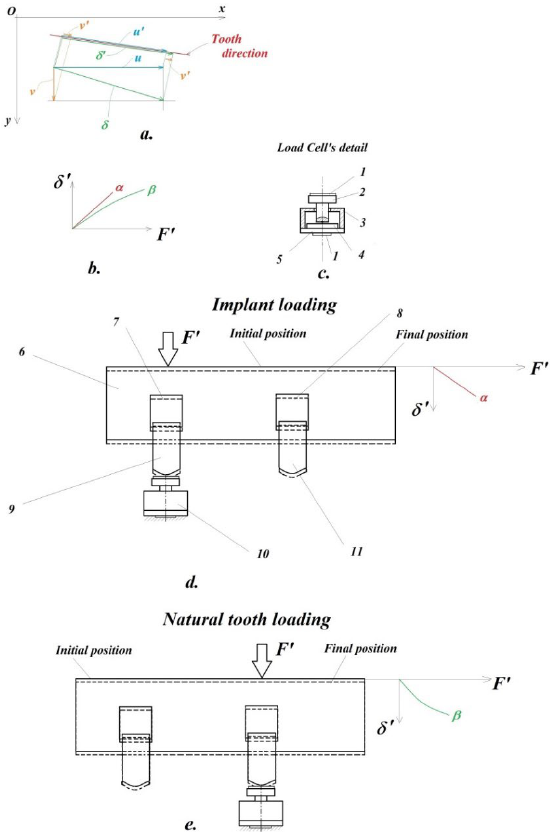
Figure 4. Supplementary details on the analyzed phenomenon: ( a )—projections’ calculi; ( b )—linear-, as well as curvilinear characteristic curves; ( c )—load cell’s detail; ( d )—plan-parallel movement of the teeth when the implant is loaded; ( e )—plan-parallel movement of the teeth when the natural tooth is loaded.